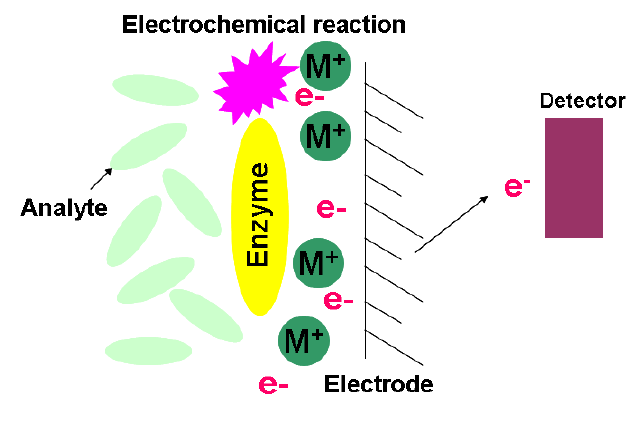
Figure 6. Schematic configuration of an electrochemical